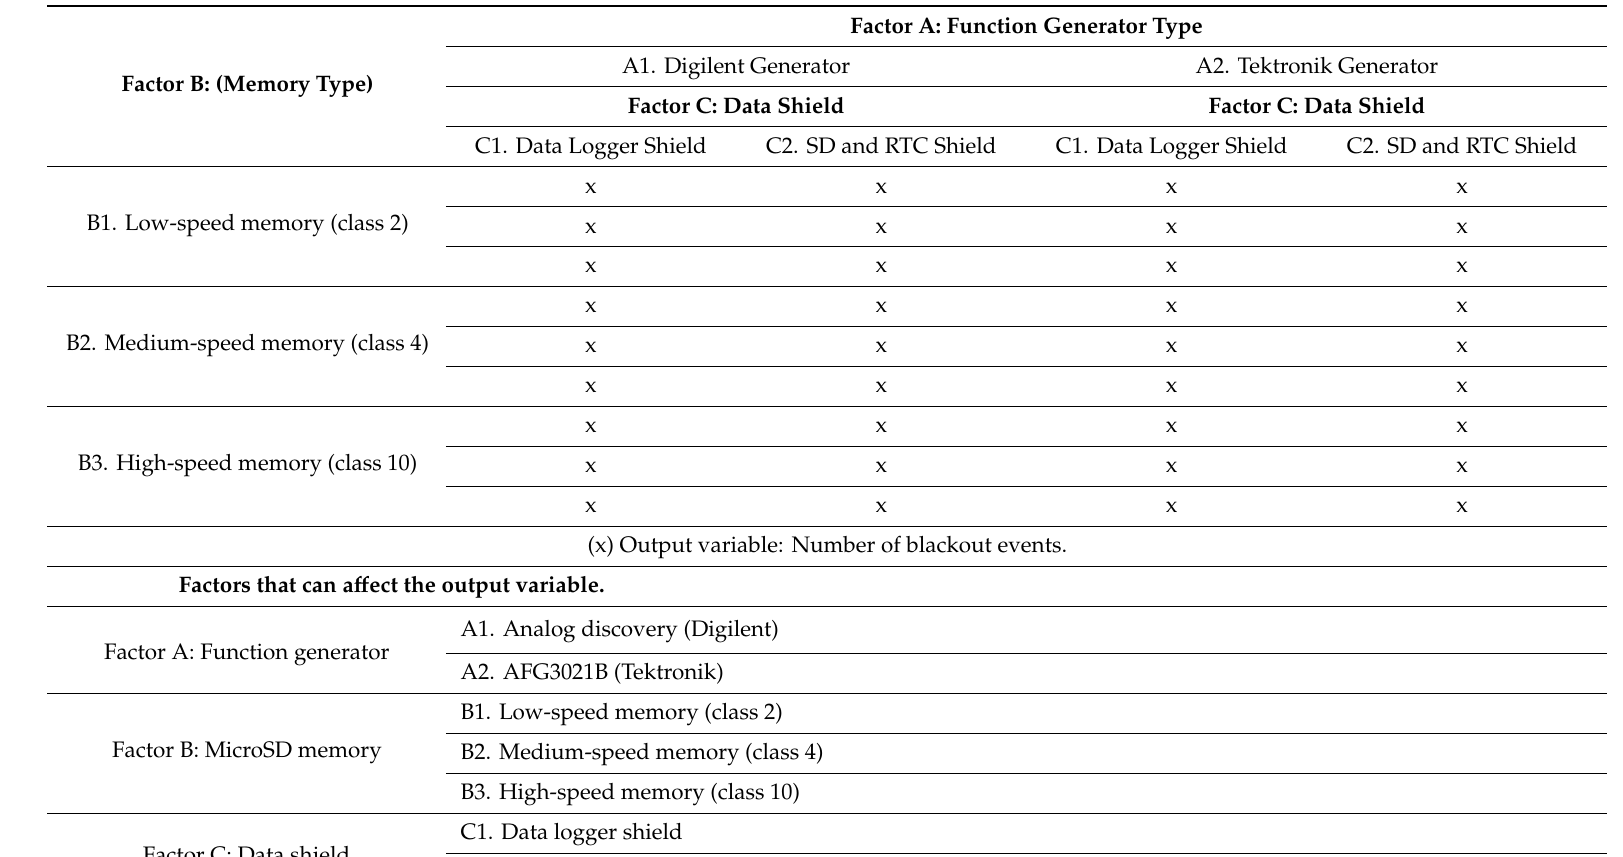
Table 3. Structure of design of experiments. Once the three factors are identified (Figure 11), they are placed in a table that expresses the possible combinations between them. The identified factors are as follows: (A) function generator, (B) SD card memory type, (C) error per data logger shield. For the purpose of this experiment, it was agreed that three repetitions of each combination were su ffi cient. In the cells marked with “x,” the number of blackout events must be placed, being the output